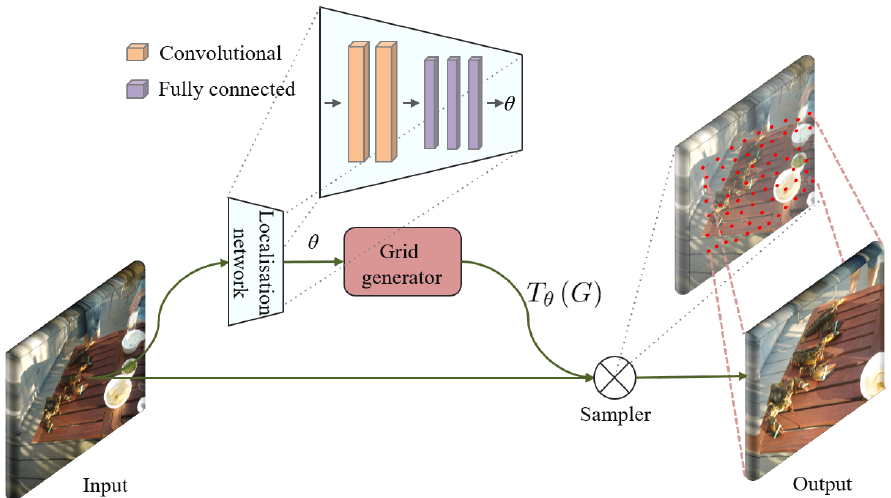
Figure 2. Illustration of a spatial transformer module architecture. The input feature maps X is fed into a localization network, which regresses the transformation parameters θ . The regular spatial grid G over output is transformed to the sampling grid T θ ( G ) which is applied to input to generate the warped output feature map X st